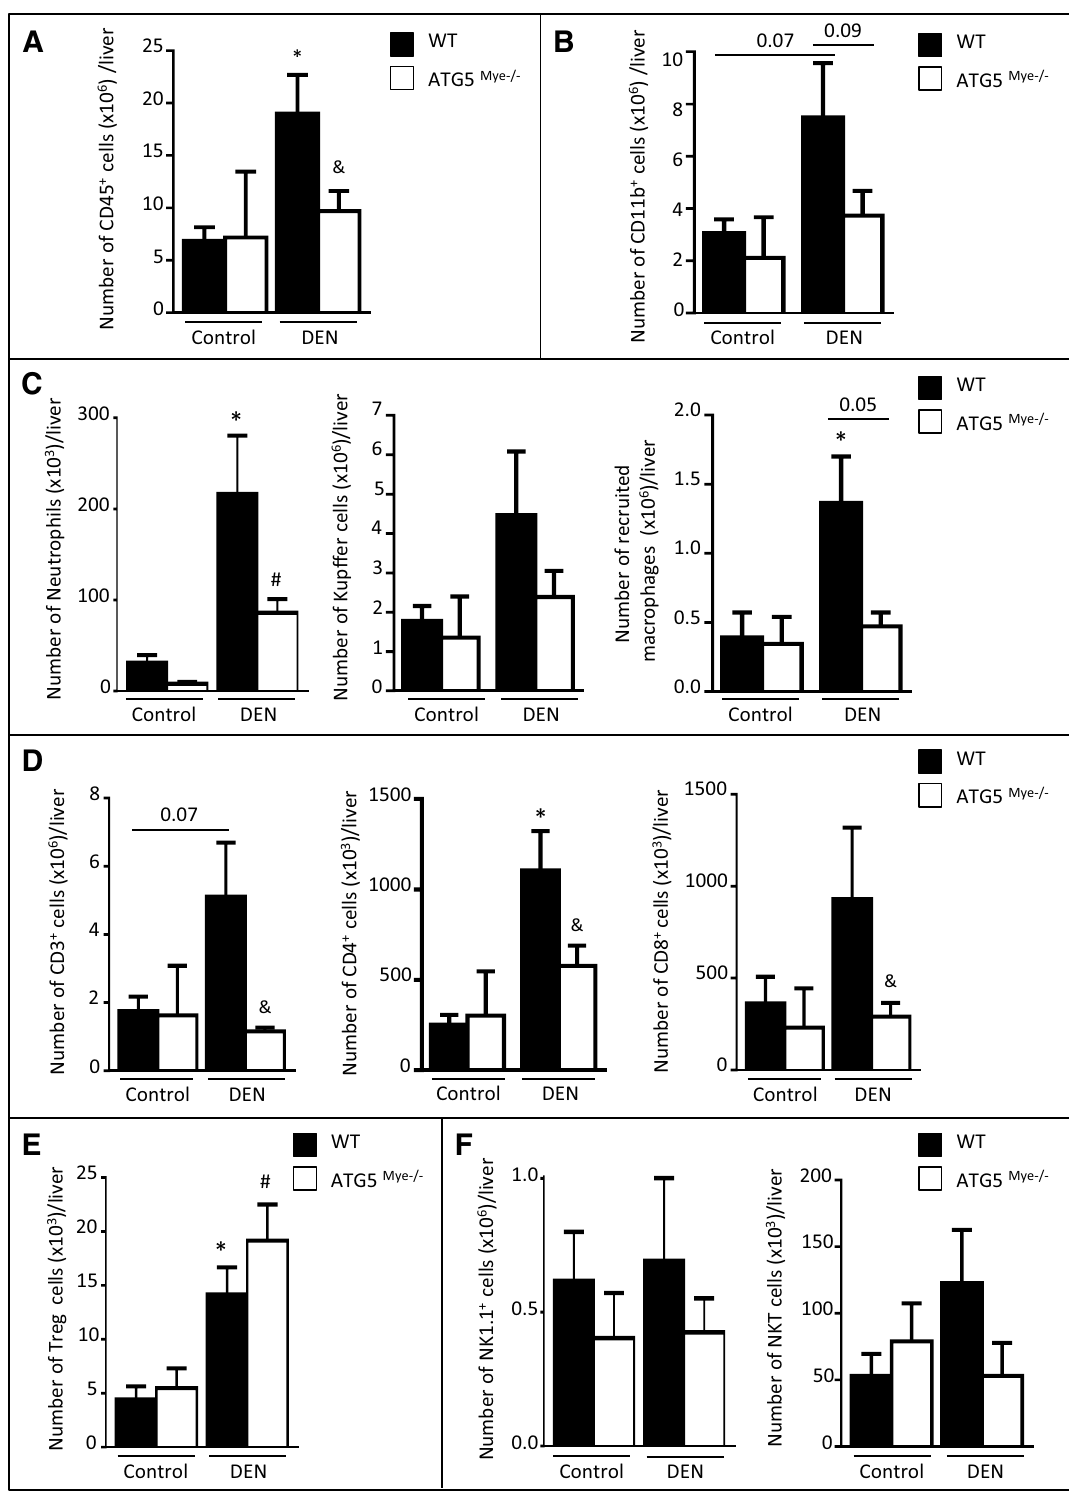
Figure 2. Macrophage autophagy deficiency alters the hepatic immune microenvironment after DEN challenge. Number of CD45 + cells ( A ), CD11b + cells ( B ), neutrophils, Kupffer cells and recruited macrophages ( C ), CD3 + , CD4 + and CD8 + T cells ( D ), Treg cells ( E ), NK cells and NKT cells ( F ) per liver in WT or ATG5 Mye−/− mice 10 months after DEN or saline solution administration. Data are shown as mean ± SEM. *p < 0.05 for WT Control vs WT DEN, # for ATG5 Mye−/− Control vs ATG5 Mye−/− DEN and & p < 0.05 for WT vs ATG5 Mye−/− . n = 6–14 for WT mice Control; n = 3–10 for ATG5 Mye−/− mice Control; n = 3–14 for WT mice DEN; n = 4–26 for ATG5 Mye−/− mice